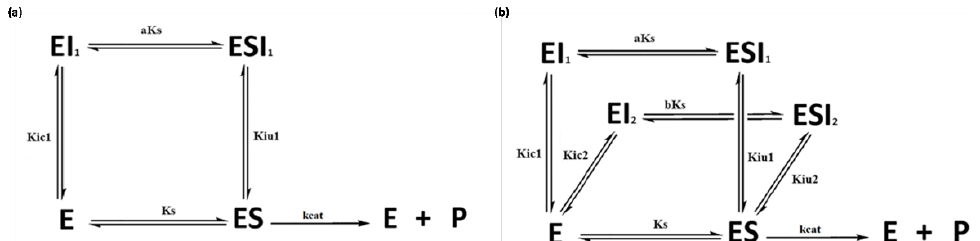
Figure 1. ( a ) Mixed linear inhibition model (MI), where: E — enzyme; ES — complex enzyme inhibi- tor; ESI — complex enzyme inhibitor substrate; EI — complex enzyme inhibitor; P — product; Km — Michaelis – Menten constant; K ic , K iu — dissociation constants; k cat — catalytic constant. ( b ) Kinetic mechanism for two exclusive mixed linear inhibitors (I 1 and I 2 ) with K iu1 /K ic1 = a and K iu2 /K ic2 = b.